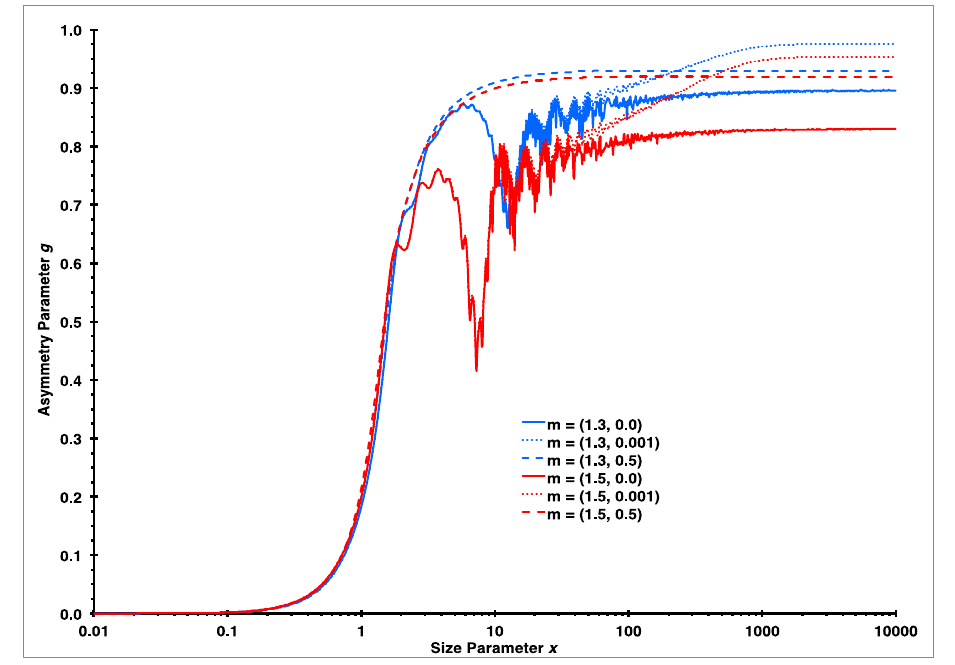
Figure 1. Mie theory asymmetry parameter g as function of size parameter x for all combinations of two real and three imaginary parts of the complex refractive indices m .